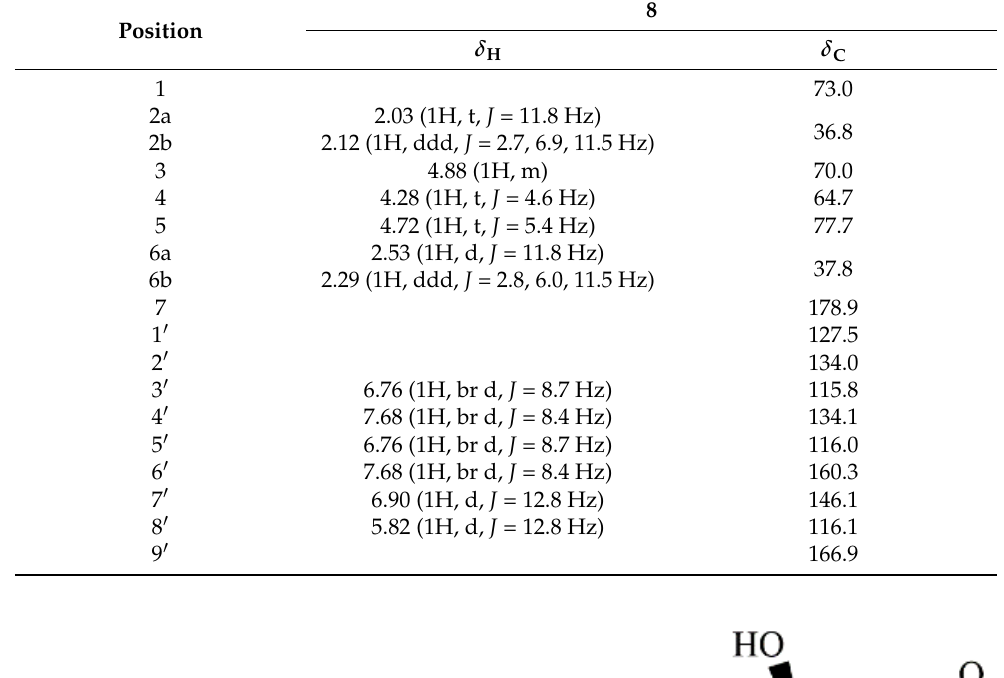
Table 1. 1 H and 13 C-NMR spectroscopic data of compound 8 .